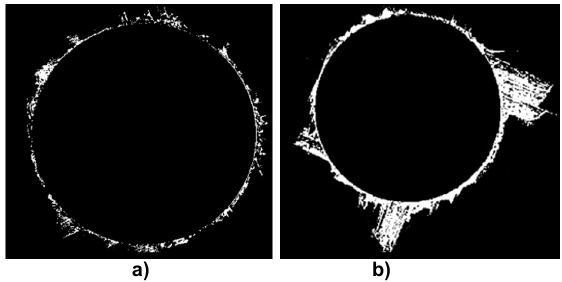
Figure 8. Damage images with minimum difference and maximum difference in Df for all three methods: a) Minimum (T1 tool, V = 110 m/min, f = 0.14 mm/rev), b) Maximum (T2 tool, V = 65 m/min, f = 0.2